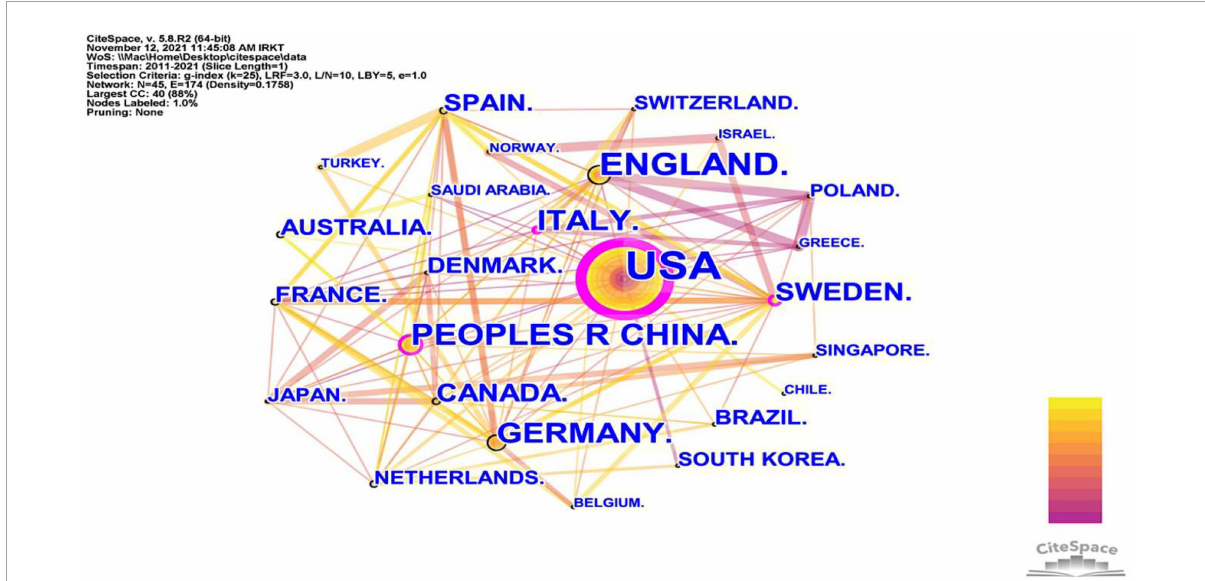
FIGURE3 The cooperation network visualizations map of countries and regions created using CiteSpace. Node and line size represent the number of publications from a country and the cooperative relationship in the country, respectively. Color represents a single time slice. The diameter of the purple outer ring represents the size of the